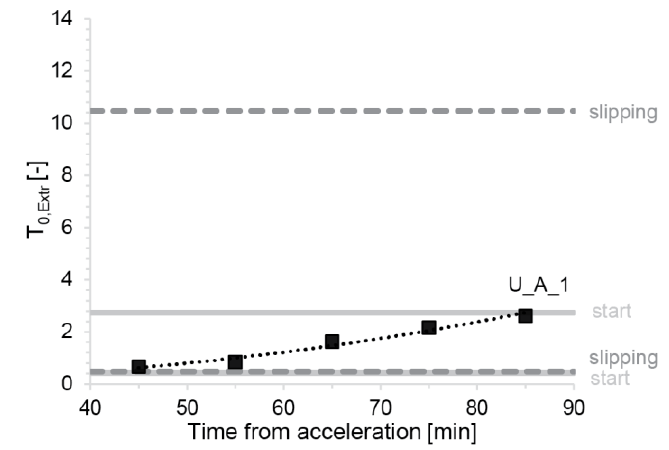
Figure A2. The process window expressed with the dimensionless yield stress for the start of slipping with a typical formwork for thin folded structures when ‘S_A_1’ material is used for the process. Materials 2020 , 13 , x FOR PEER REVIEW 22 of 24